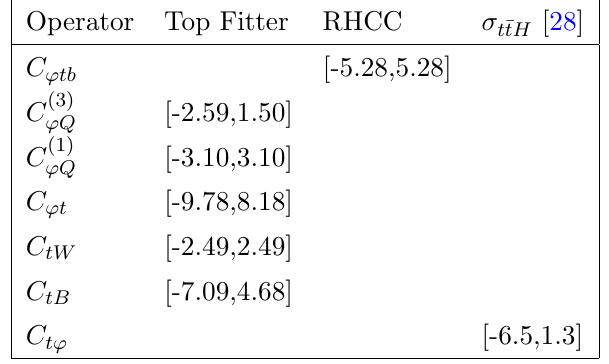
Table 8 . Individual limits on operator coe(cid:14)cients, from the Top Fitter Collaboration [5], right- handed charged currents (RHCC) (tree-level only) [9], and t (cid:22) tH cross section [28]. (cid:3) = 1 TeV is